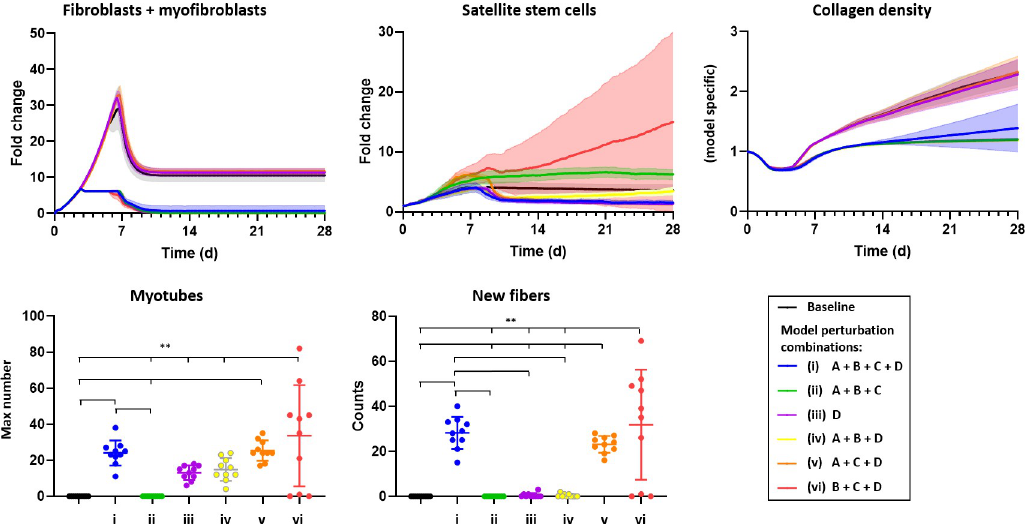
Fig 9. A combination of model parameters, reflecting the key biological aspects of failed regeneration in VML injuries, were adjusted in combination to determine how these perturbations affected collagen density and new muscle fiber infiltration into the defect. In perturbation “A”, the maximum number of M1 macrophages and in perturbation “B”, the maximum number of fibroblasts were reduced to 75% of baseline levels. In perturbation “C”, SSC migration behaviors were adjusted such that SSCs preferred being in isolation on ECM as opposed to in their niche next to a fiber. Model perturbation D, which corresponded to the threshold for SSC differentiation into myofiber, was reduced so that SSC differentiation was more frequent. When perturbations, C and D, were implemented simultaneously, then there was a significant increase in the number of myotubes and new fibers. �� p < 0.01, statistical significance between groups using a one-way analysis of variance and Holm-Sidak post hoc